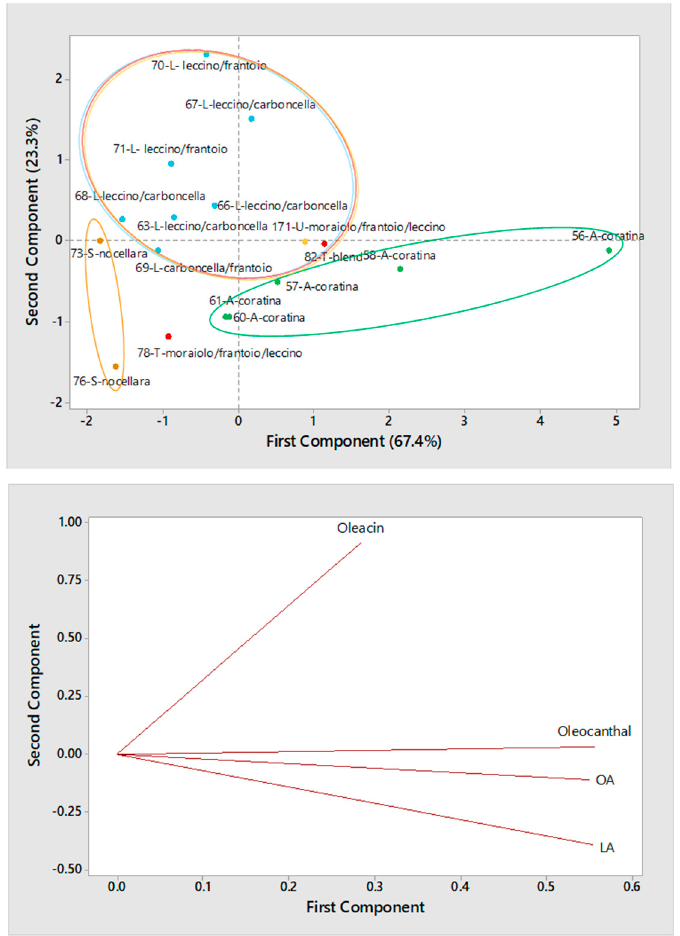
Figure 8. Score plot ( top panel ) and Loading plot ( bottom panel ) referred to the first two components provided by Principal Components Analysis (PCA) based on average normalized peak areas obtained for OA, LA, oleacin and oleocanthal (including the contribution of their carboxylic derivatives, if present) after the RPLC-ESI(-)-FTMS analysis of two replicated extracts for each of 17 Italian EVOOs produced during the 2017/2018 campaign using a three-phase decanter for horizontal centrifugation. Samples are labelled according to number (see Table 1), region (A = Apulia, L = Lazio, S = Sicily, T = Tuscany, U = Umbria) and cultivar.